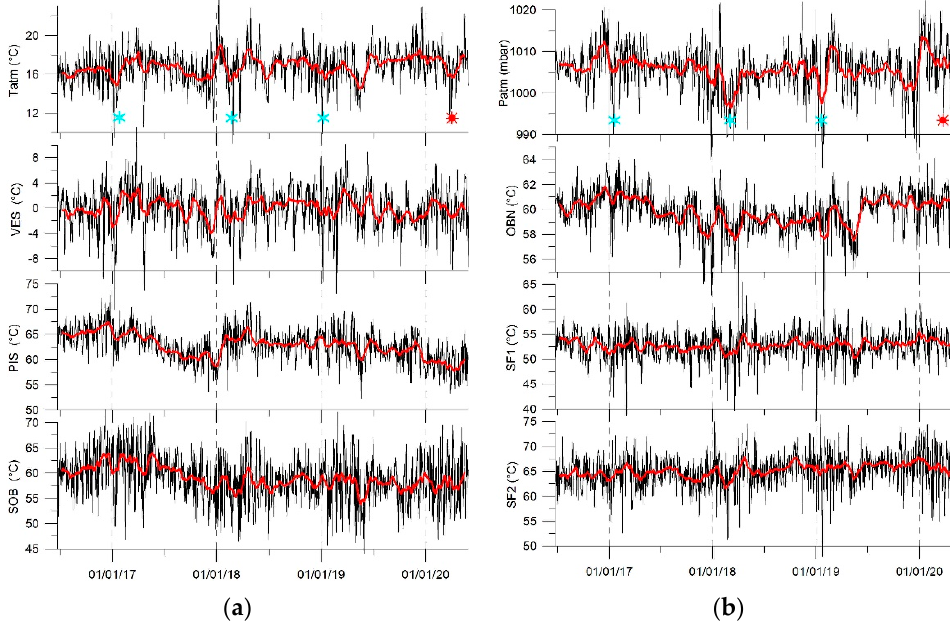
Figure 2. Analyzed time-series of ground temperatures: ( a ) from top to bottom, T atm , VES, PIS and SOB (black lines); ( b ) from top to bottom, P atm , OBN, SF1 and SF2 (black lines), as indicated by the vertical axis labels. The red curves are the moving averages, estimated over 31-day-long time windows shifted by 1 day. In the plot of T atm and P atm , we added cyan stars in correspondence to exceptional snowfalls. A red star marks the 2020 lockdown due to the COVID-19 pandemic.